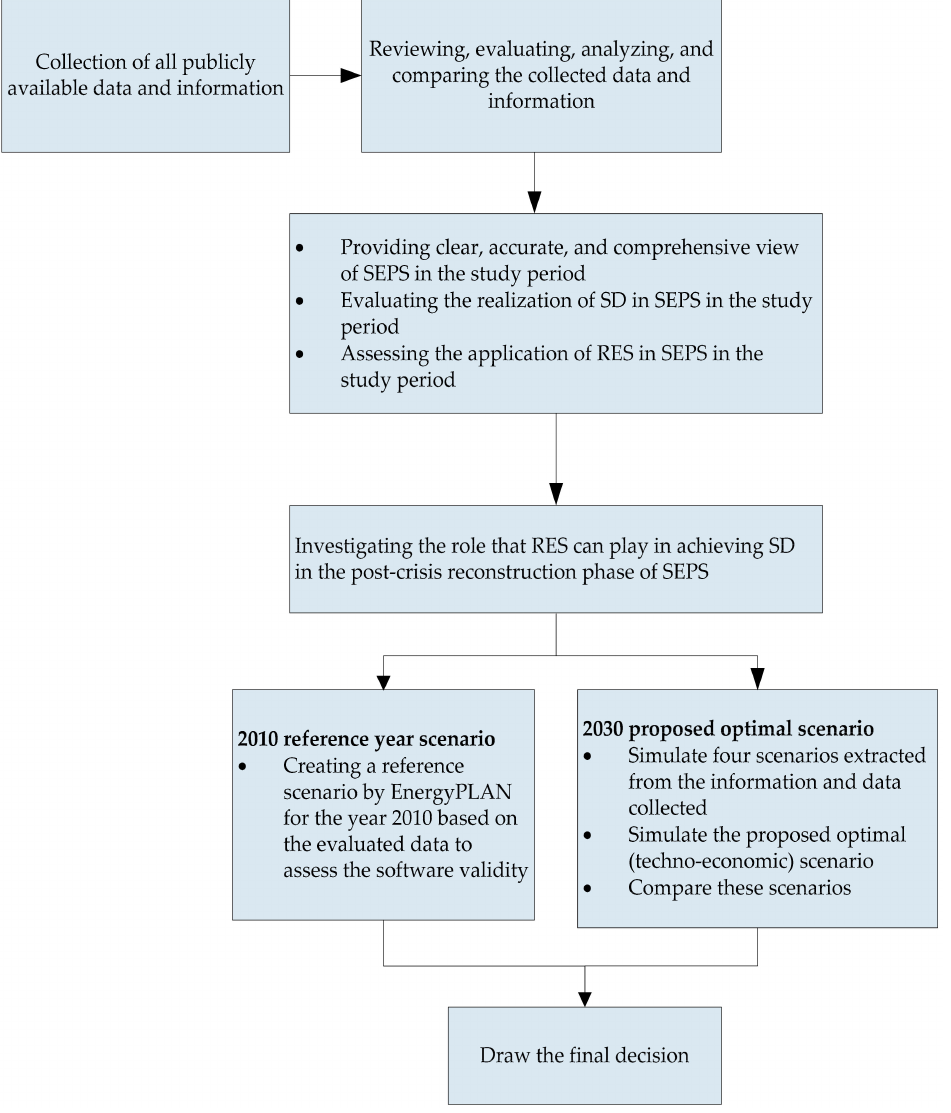
Figure 1. Summary of the adopted methodology. Table 1. Year of installation, installed capacity, year of expansion, and expansion capacity of the SEPS’s generation stations until